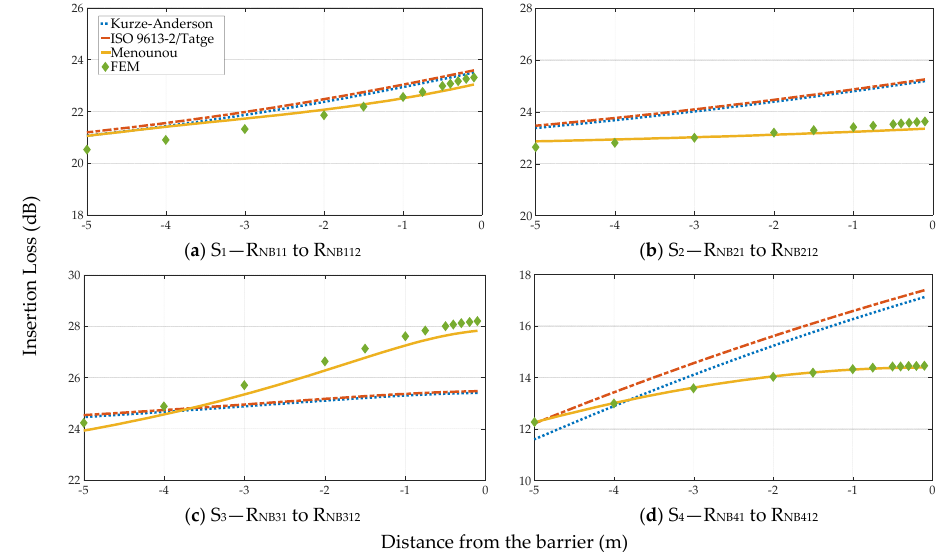
Figure 8. Comparison of calculation of insertion loss between FEM and various formulae for various source and receiver positions near the barrier inside the shadow zone (300 Hz).